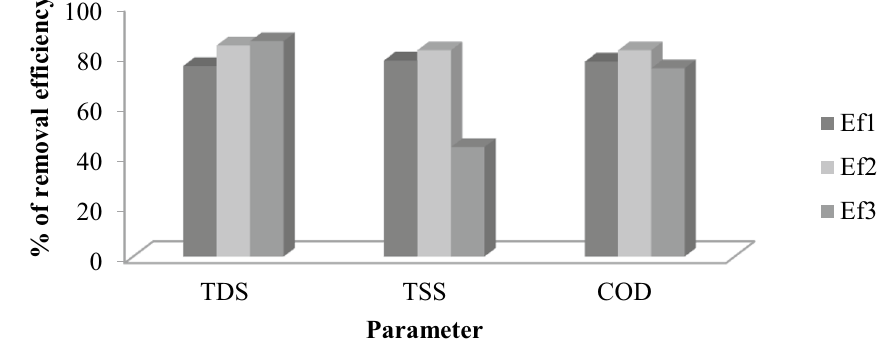
Fig. 6 Percentage removal of TDS, TSS and COD from efflu- ents after treatment with PAC coagulant